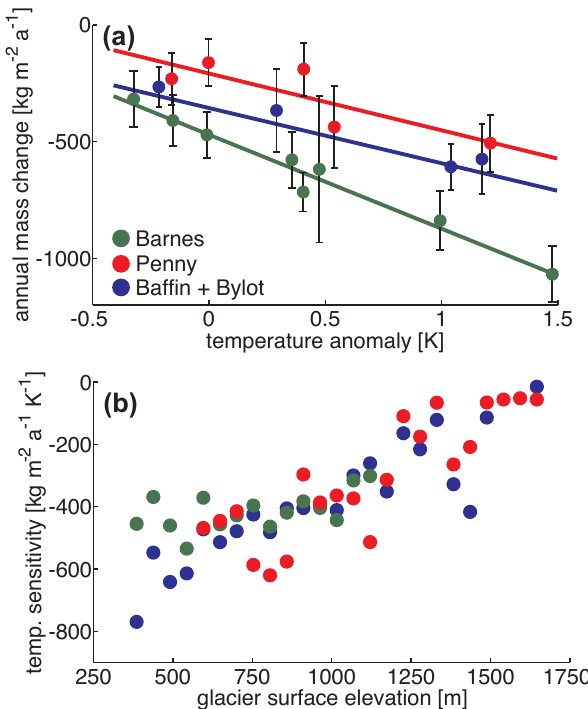
Fig. 10. (a) Glacier area-averaged annual mass change with 95% confidence intervals plotted against NCEP R1 summer (June, July, August) glacier area-averaged 700mb temperature anomalies for each mass change measurement interval. Anomalies are relative to the 1960–2010 means. Lines show linear fits with the following slopes: Barnes= − 405 ( r = − 0 . 99), Penny= − 245 ( r = − 0 . 84), and Baffin and Bylot Island glaciers= − 238 ( r = − 0 . 84) with units of kgm − 2 a − 1 per 1 ◦ C increase in temperature. (b) Annual mass change sensitivity with respect to glacier area-averaged 700mb summer temperature as a function of glacier surface elevation. (b) shows that glacier surfaces are most sensitive to changes in sum- mer temperature at lower